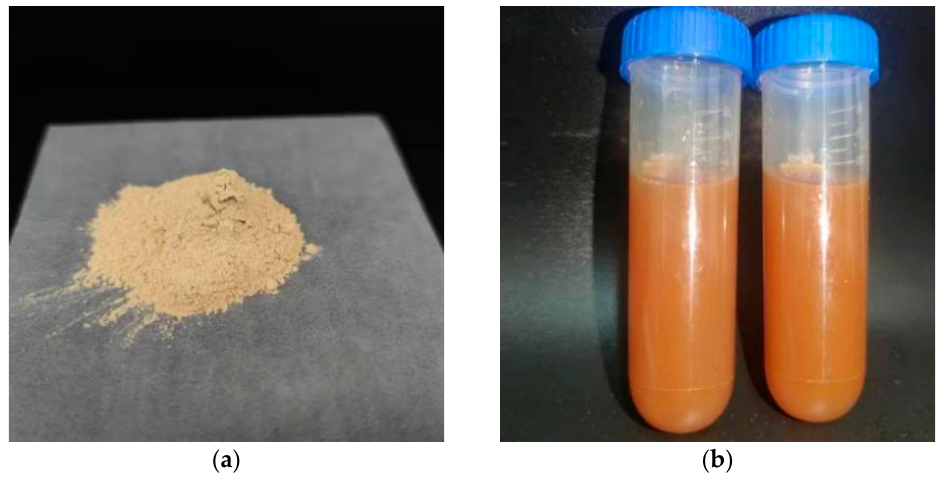
Figure 1. RIR powder ( a ); the supernatant solution of RIR-NaOH ( b ).